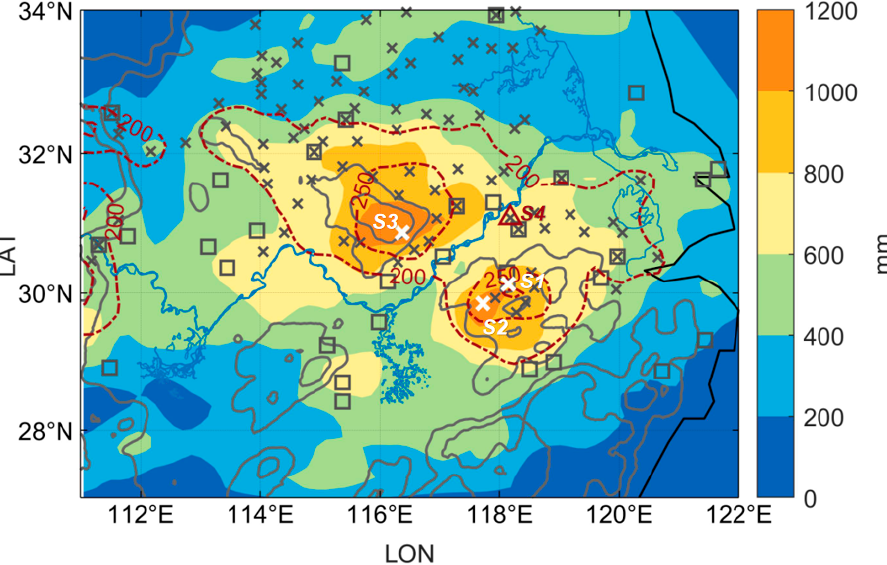
Figure 13. The accumulated rainfall deviation (shading) and hourly rainfall frequency deviation (red dashed contours) during June–July 2020, from the climate mean of the Meiyu seasons in 1980–2019. The rain gauge stations that recorded the hourly rainfall frequency exceeding 4 standard deviations in June–July 2020 are marked by grey crosses, and those that recorded a maximum hourly rainfall deviation exceeding 2 standard deviations are marked by grey squares. The location of national rain gauges receiving an accumulated rainfall over 1500 mm in June–July 2020 are marked by white crosses (S1: 1719.5 mm; S2: 1667.5 mm; and S3: 1581.6 mm), and all of them had a standard deviation greater than 4. The location of rain gauges with maximum hourly rain rates (S4) during June–July 2020 are marked by red triangles.